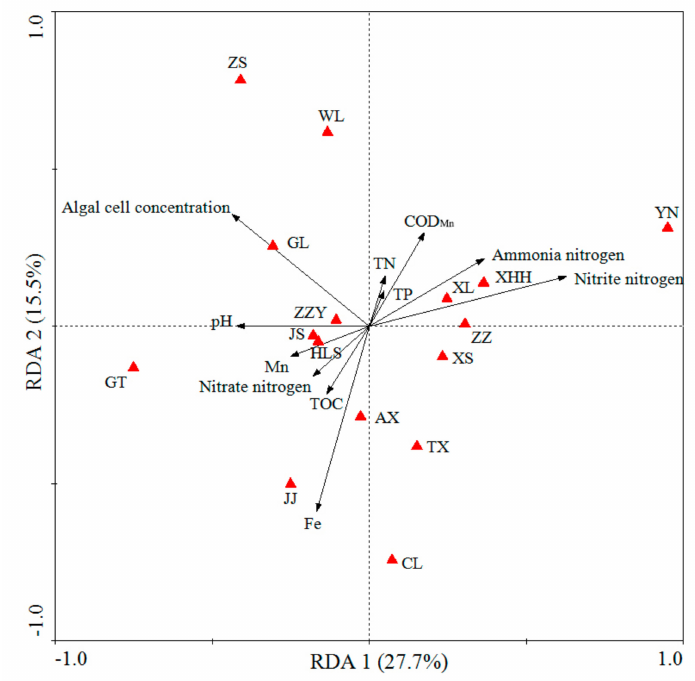
Figure 7. Redundancy analysis (RDA) of water algal communities in 16 geographically distributed urban lakes. Red triangles represent sampling points. For algal community, RDA1 explained 27.7% and RDA2 explained 15.5% of the total variance. The factors of the water quality data are represented by arrows (TN = total nitrogen; TP = total phosphorus; TOC = total organic carbon). Water quality parameters that significantly correlated with algal community diversity are